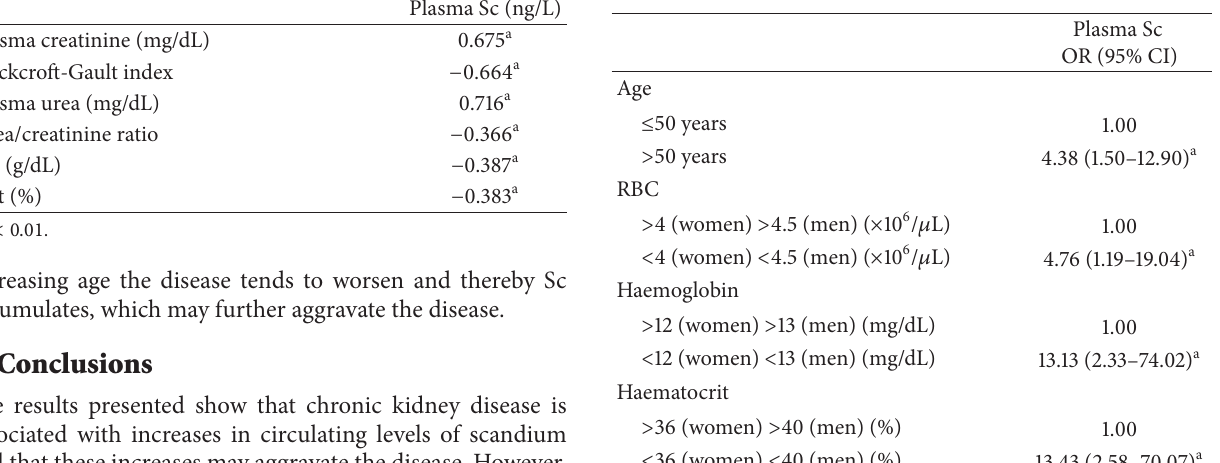
Table 5: Significant odds ratio and 95% confidence intervals, for plasma Sc by the anthropometric, biochemical, and haematological variables